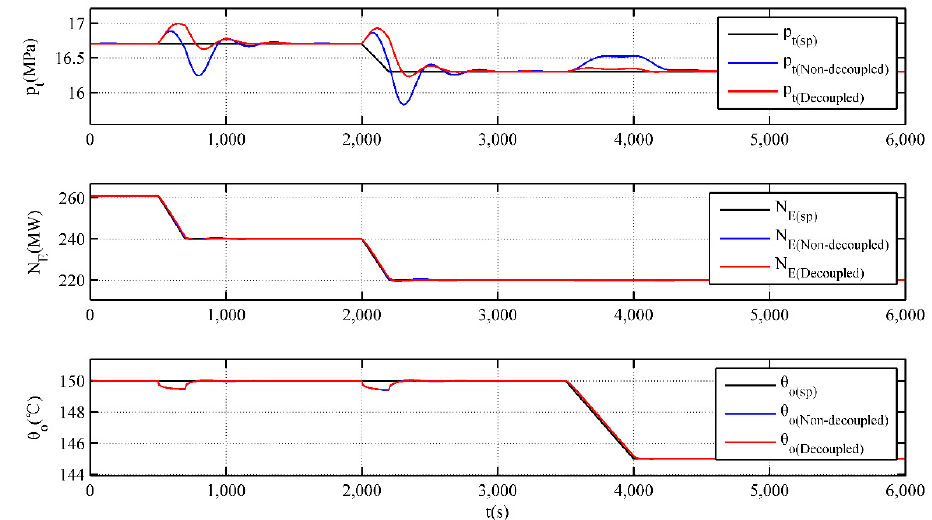
Figure 5. Curves for controlled variables.